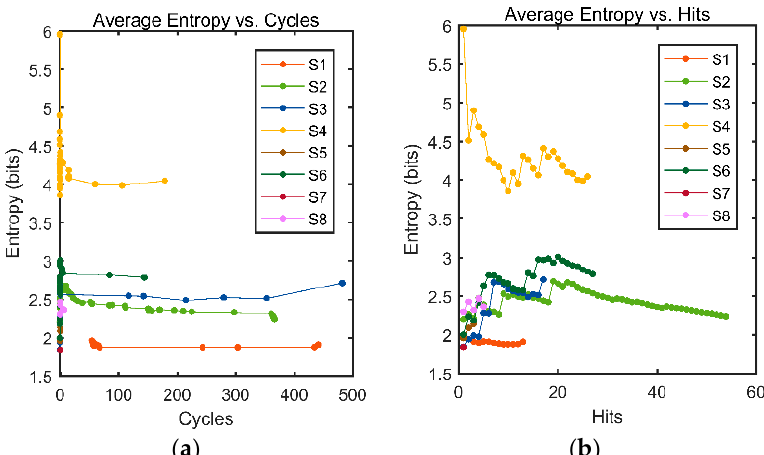
Figure 11. Average entropy trends versus fatigue cycles and hit count over the first 500 cycles: ( a ) average entropy versus cycles; and ( b ) average entropy versus hits. Appl. Sci. 2017 , 7 , 562